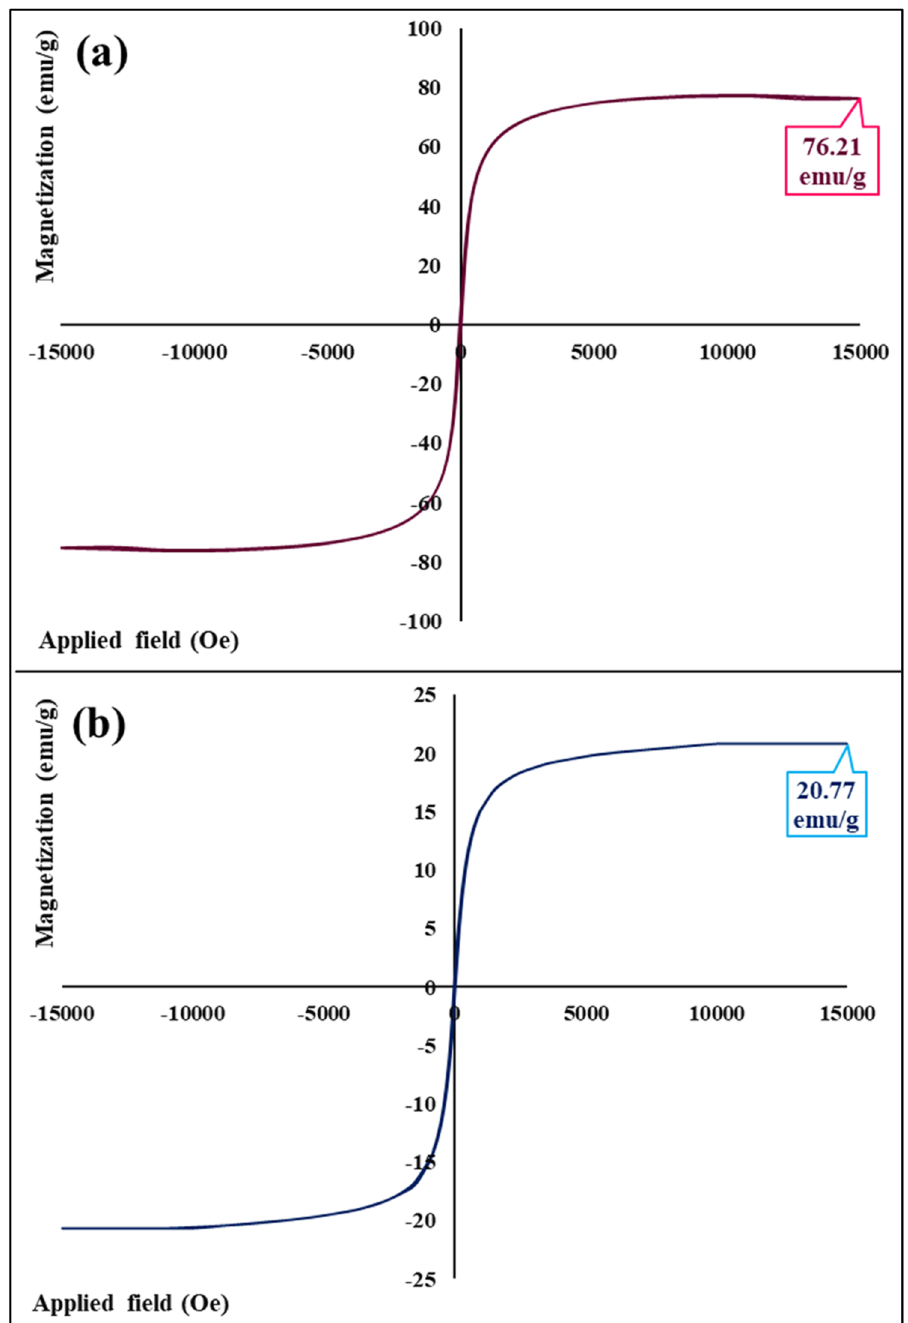
Figure 5. Hysteresis loop curves of ( a ) unfunctionalized Fe 3 O 4 MNPs, and ( b ) magnetic Fe 3 O 4 @SiO 2 @ CPTMS@DA